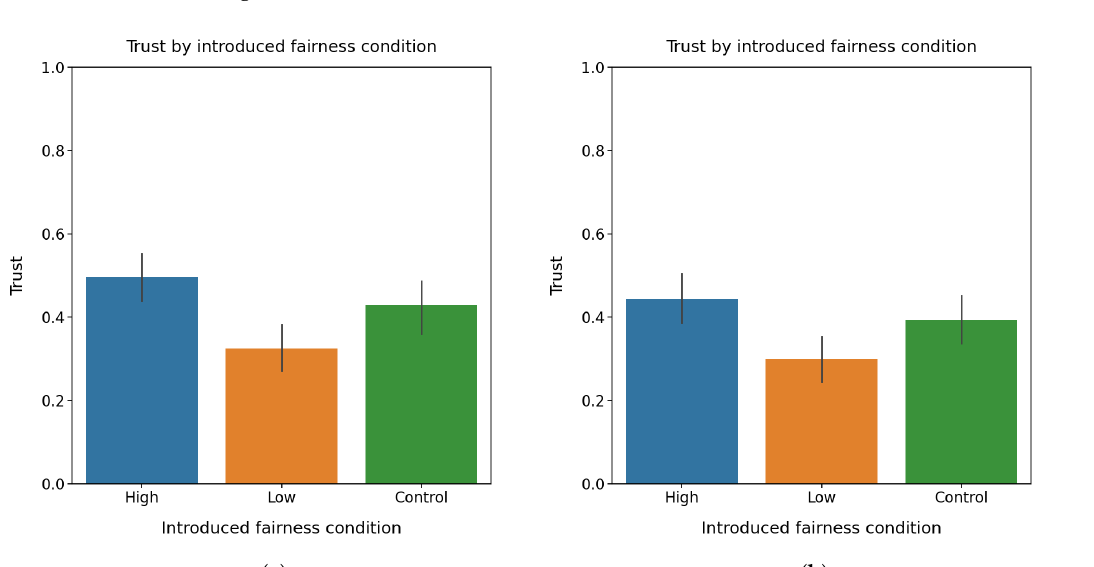
Figure 10. User trust over introduced fairness in two scenarios. ( a ) Health insurance